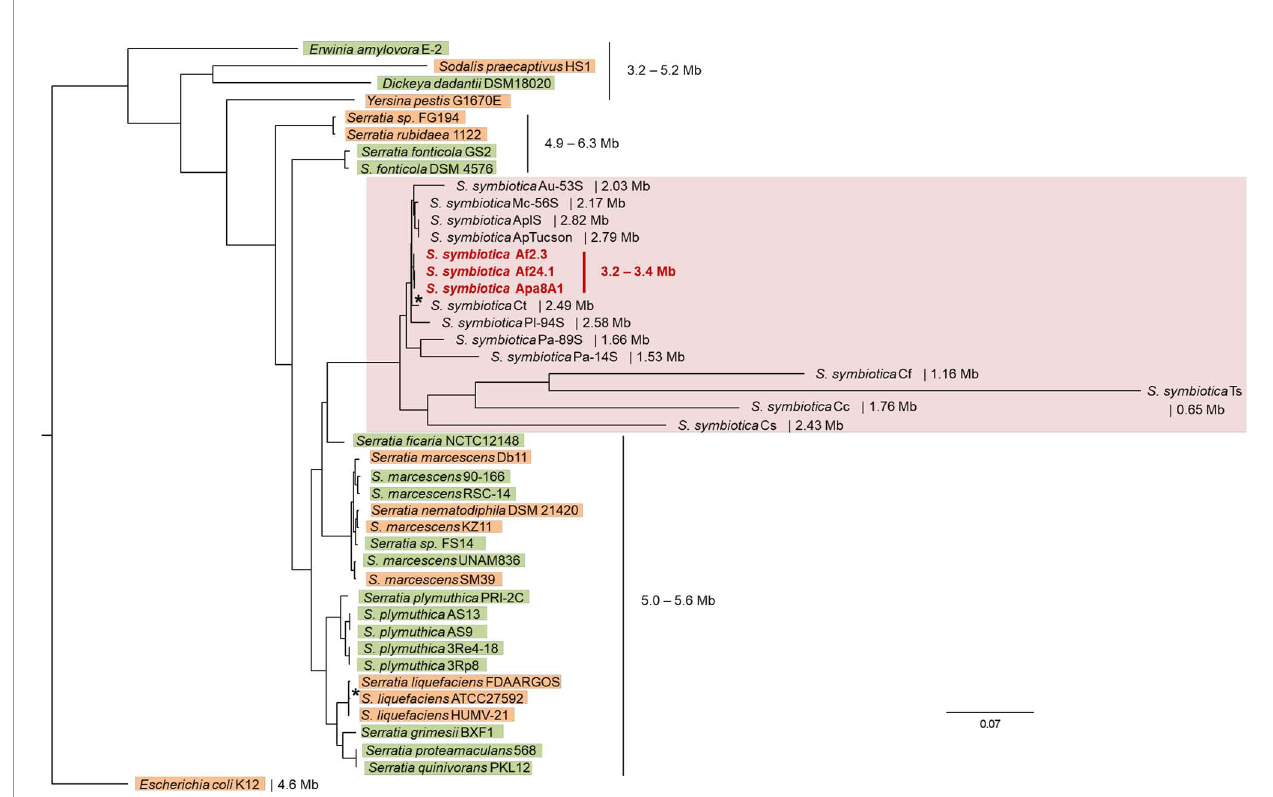
FIGURE 4 | Phylogenetic positioning of the culturable S. symbiotica strains in the species and in the genus. The tree shown is the maximum likelihood topology inferred with IQ-TREE on 221 concatenated single-copy genes shared by all selected strains. Branch support (SH-aLRT and ultrafast bootstrap values) was > 99% for all nodes, except for two nodes associated with support values > 80% (*): ( S. symbiotica Af2.3, S. symbiotica Af24.1, S. symbiotica Apa8A1 and S. symbiotica Ct) and S. liquefaciens FDAARGOS and S. liquefaciens ATCC27592). The S. symbiotica strains are highlighted in pink and the three cultured strains are denoted in bold red. Serratia members found associated with plants are highlighted in green and Serratia members found associated with animals are highlighted in orange. Partitions and associated models in a nexus fi le available in Supplementary Material